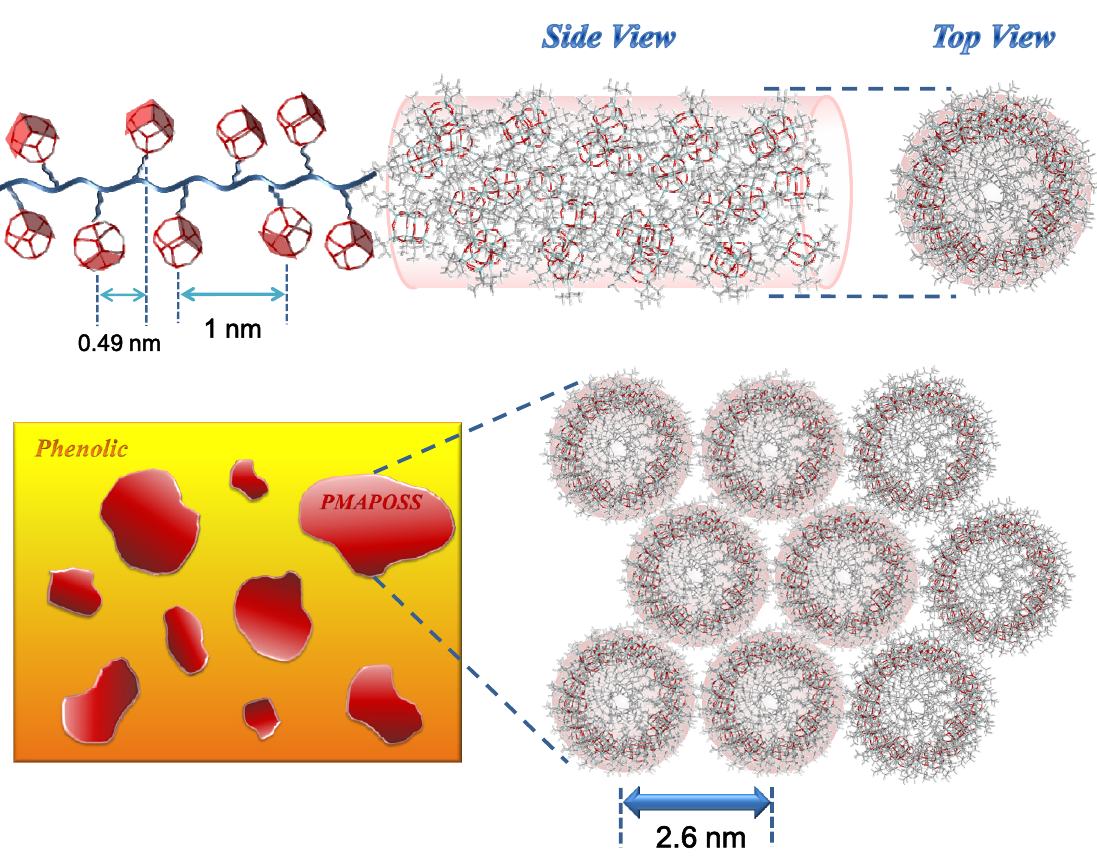
Scheme 2. Schematic illustration of relevant length scale in PMA-POSS, and helix-like